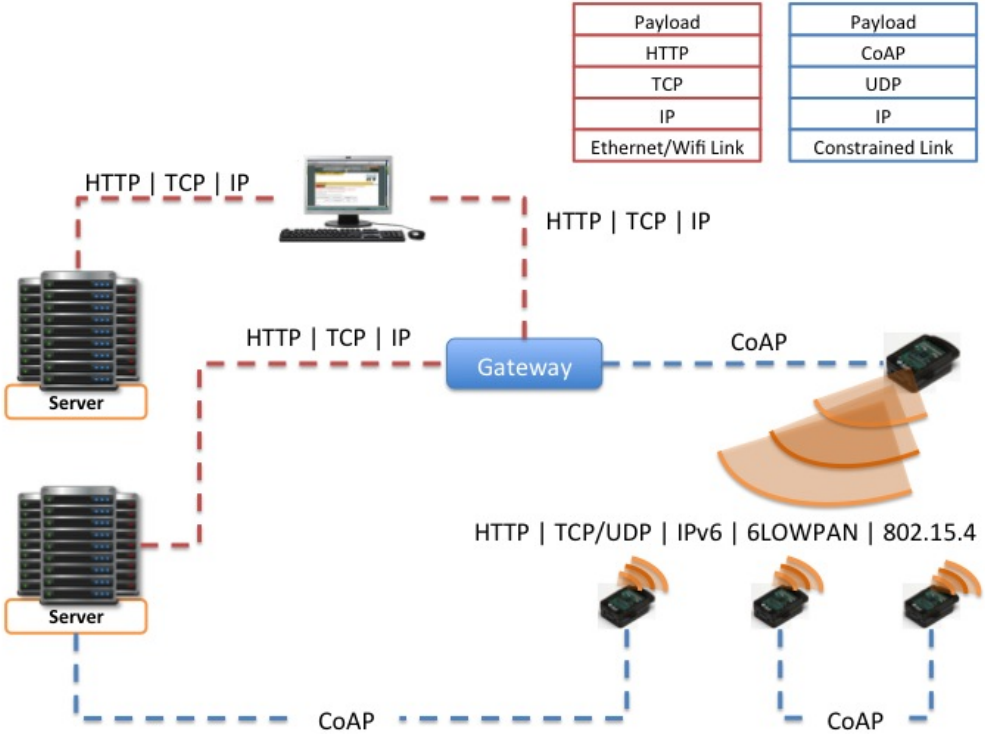
Figure 11. Description of the CoRE communications